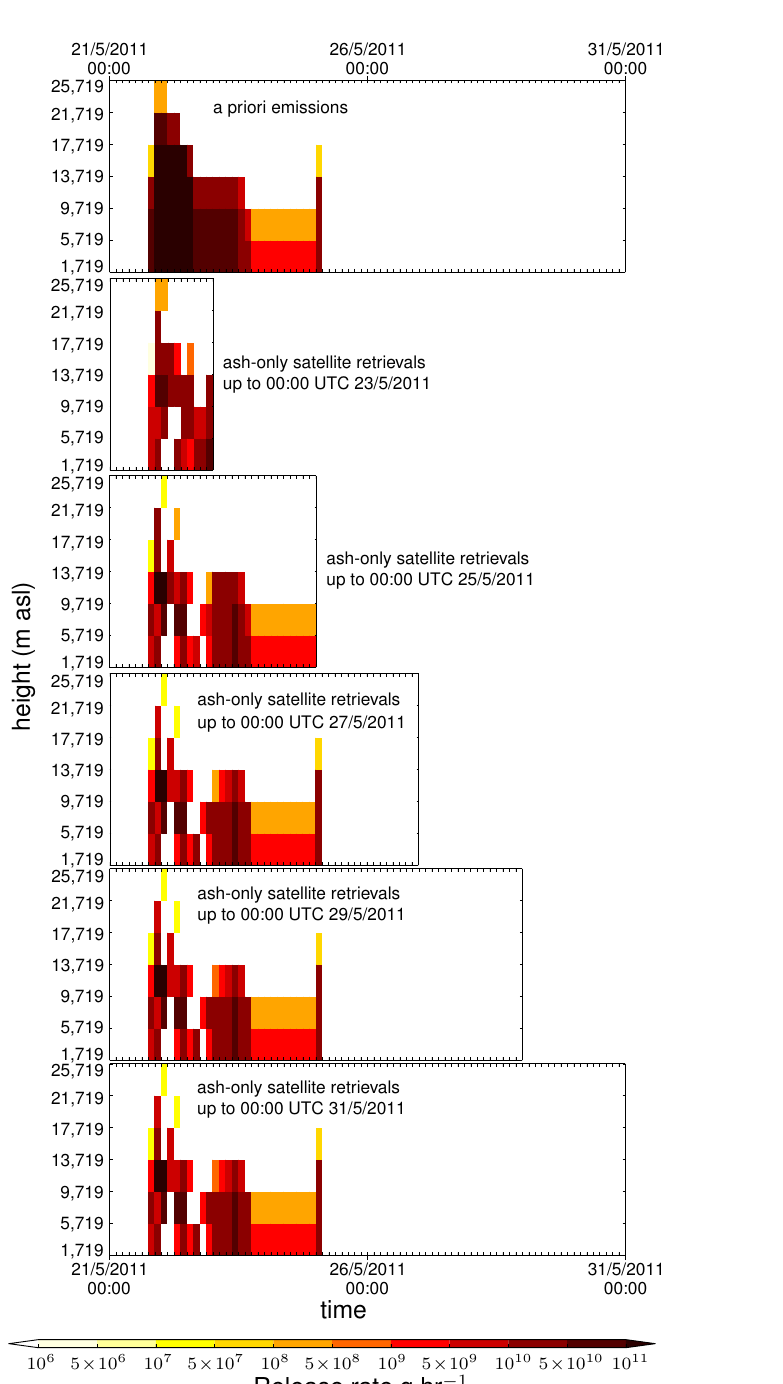
inversion source term profile using observations until 31/05/2011 00:00